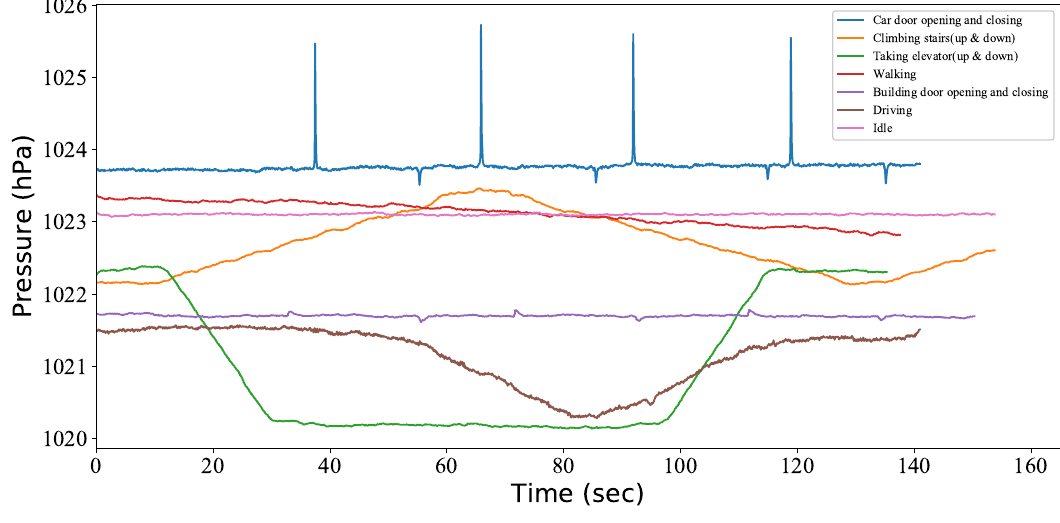
Figure 2. Atmospheric pressure variation due to user